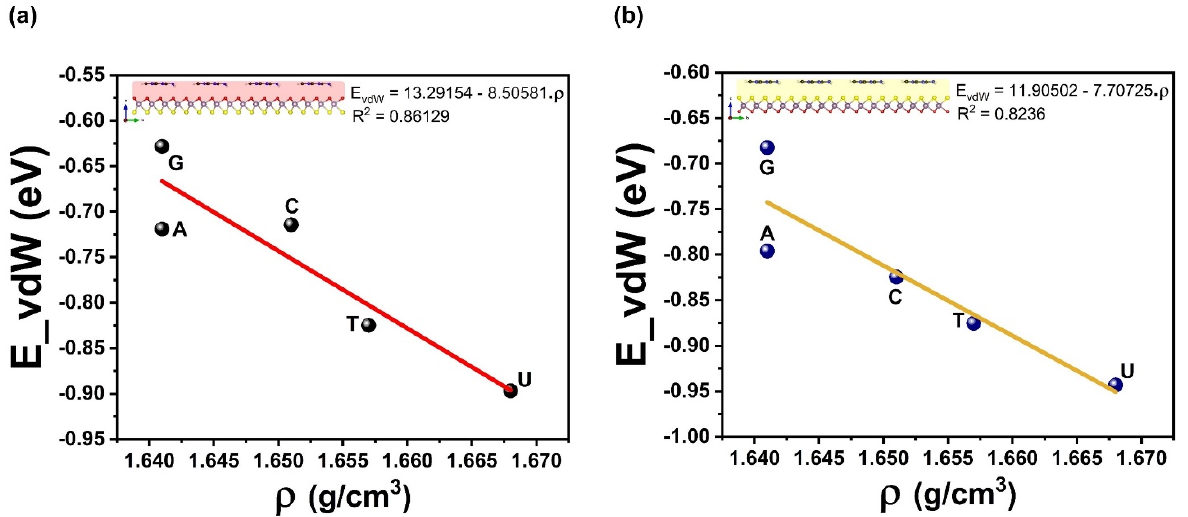
Figure 5. The van der Waals energy as function of density affinity of the nucleobases molecules on the Janus MoOS monolayer facets, ( a ) on O layer, ( b ) on S layer, respectively.